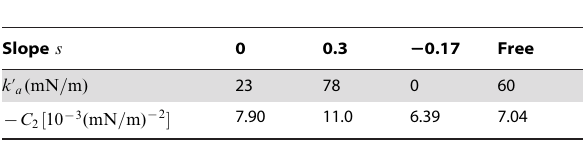
Table 4. Values of k ’ a and C 2 obtained from our model that yield the best agreement with the experimental results of Ref. [18] analyzed with the low-tension linear